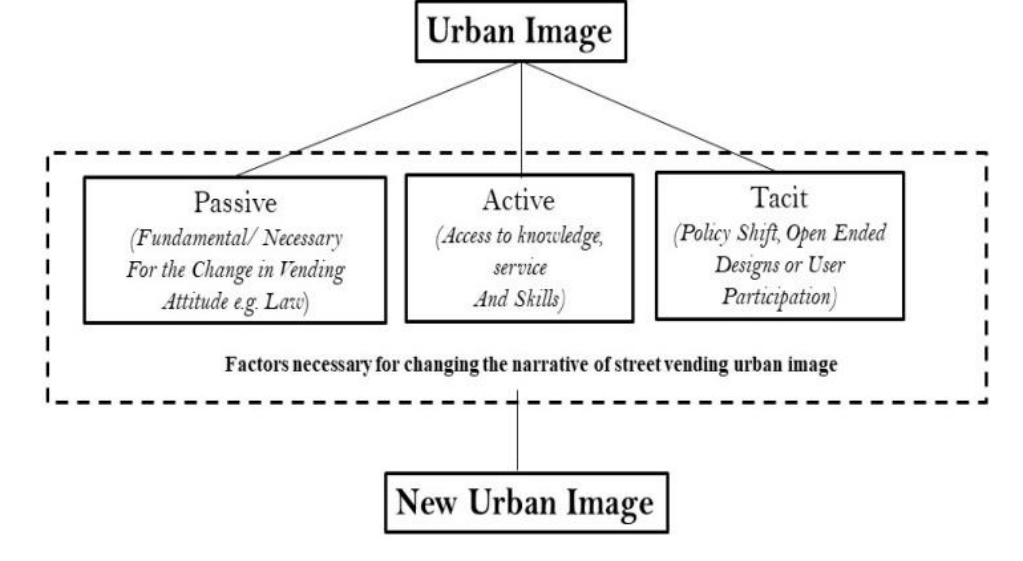
Figure 4: Proposed model for changing the narrative about street